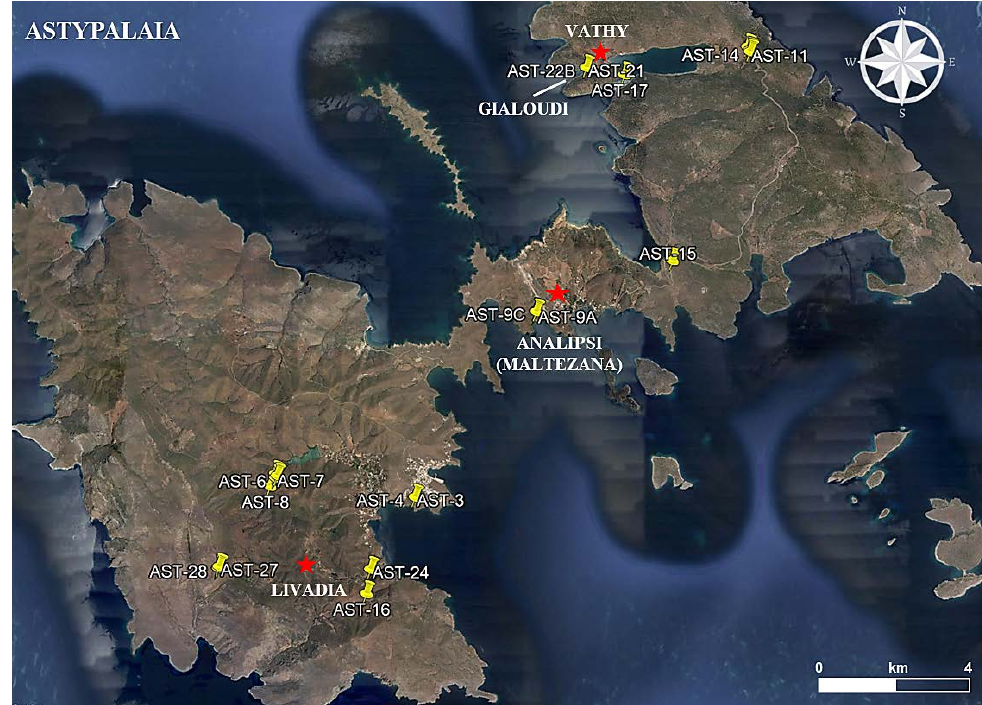
Figure 4. Oblique satellite view (Google Earth Pro) of Astypalaia island showing the sampling sites.